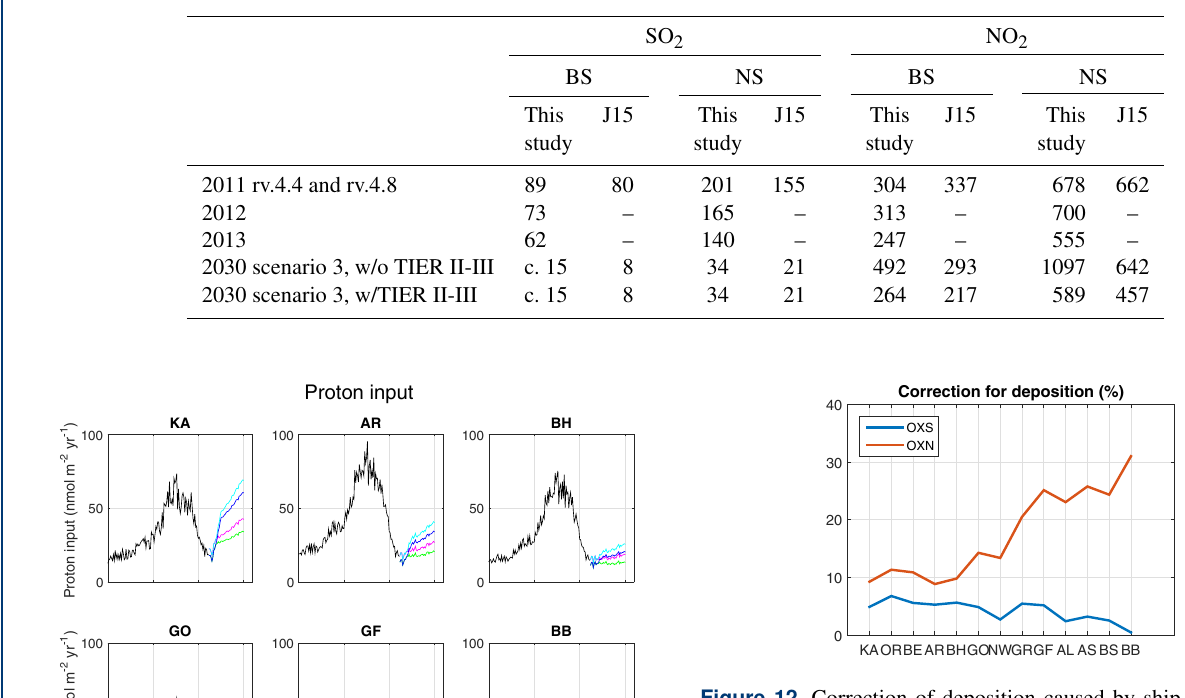
Table 4. Emissions from shipping in the Baltic Sea (Ggyr − 1 ).